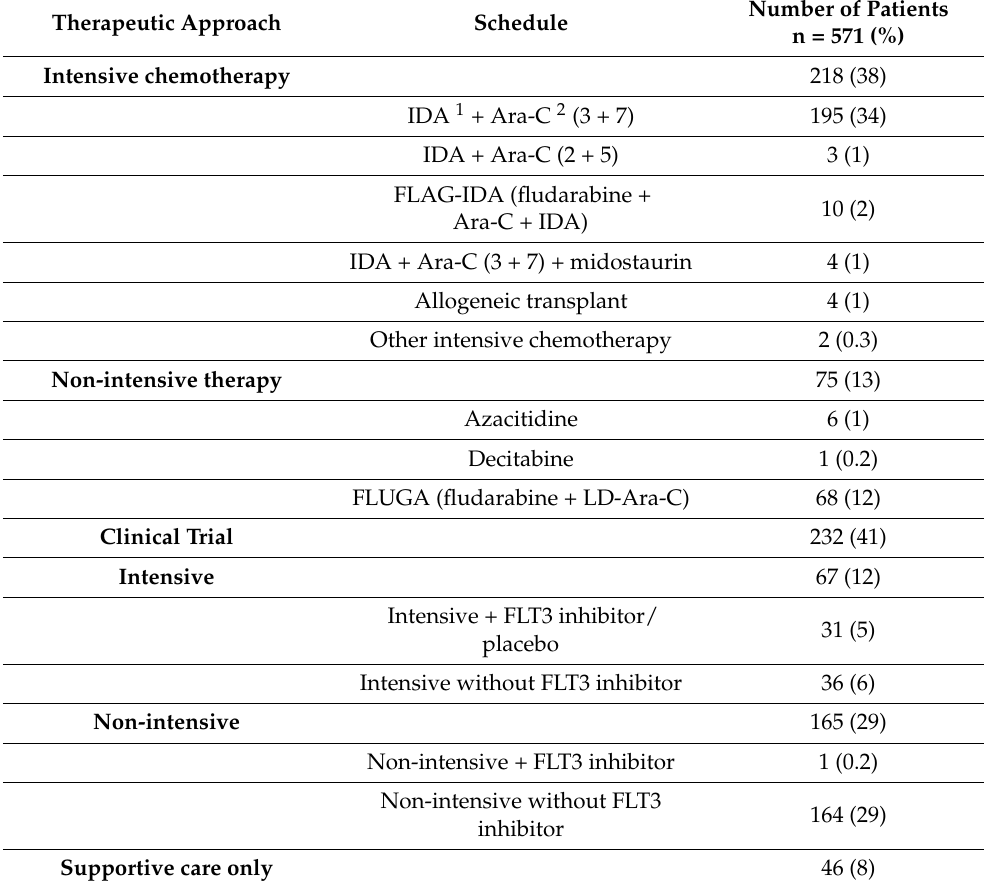
Table 1. Front-line therapeutic approach in AML patients (intensive vs. non-intensive vs. trial vs. best supportive